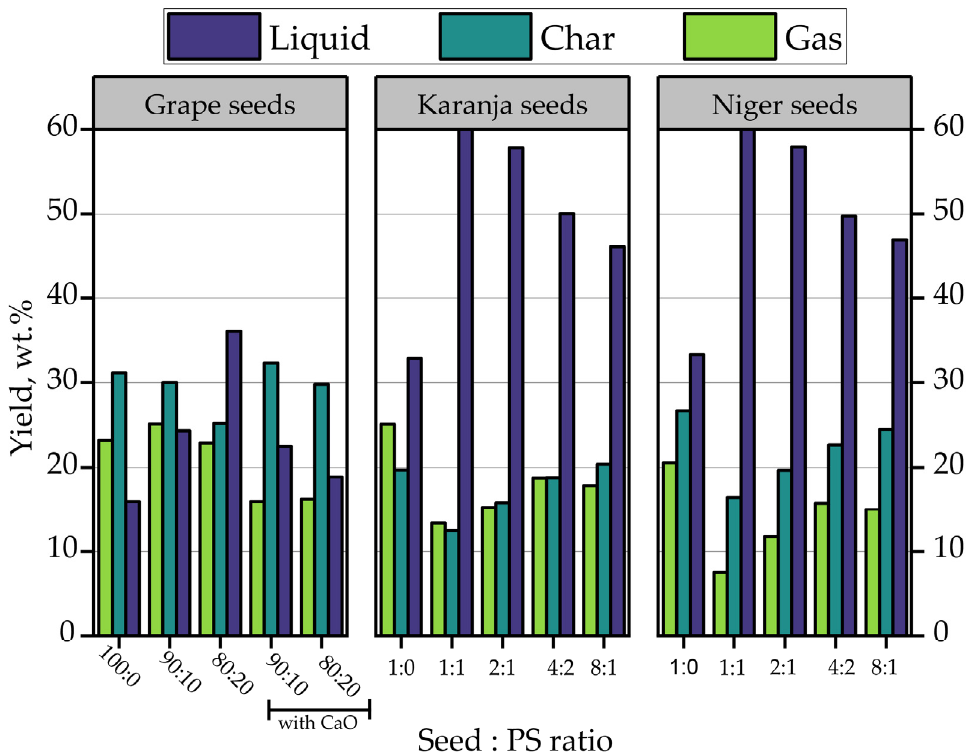
Figure 12. Co-pyrolysis of PS and various biomass seeds.